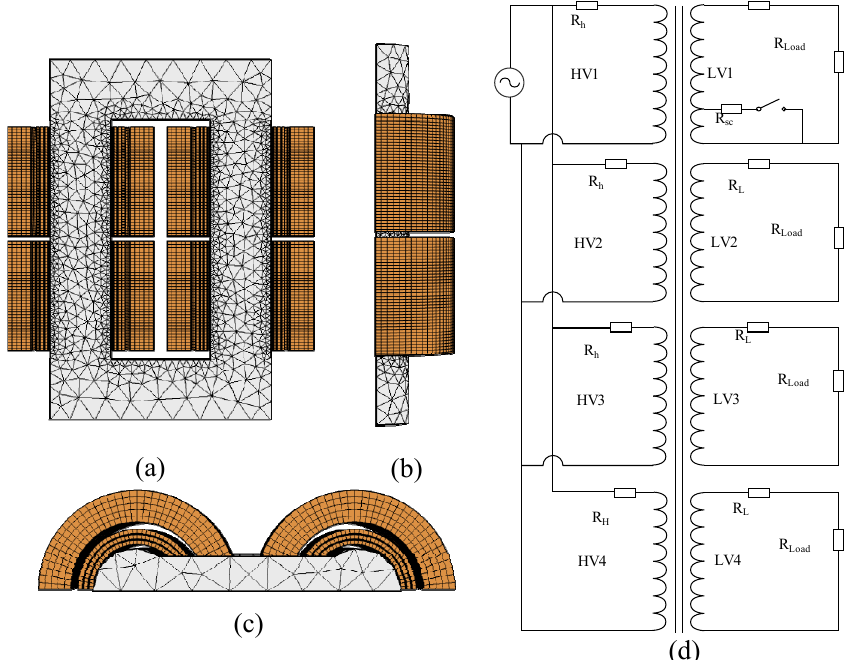
Figure 2. ( a ) Front view of meshing. ( b ) Right view of meshing. ( c ) Top view of meshing. ( d ) Field circuit coupling circuit.